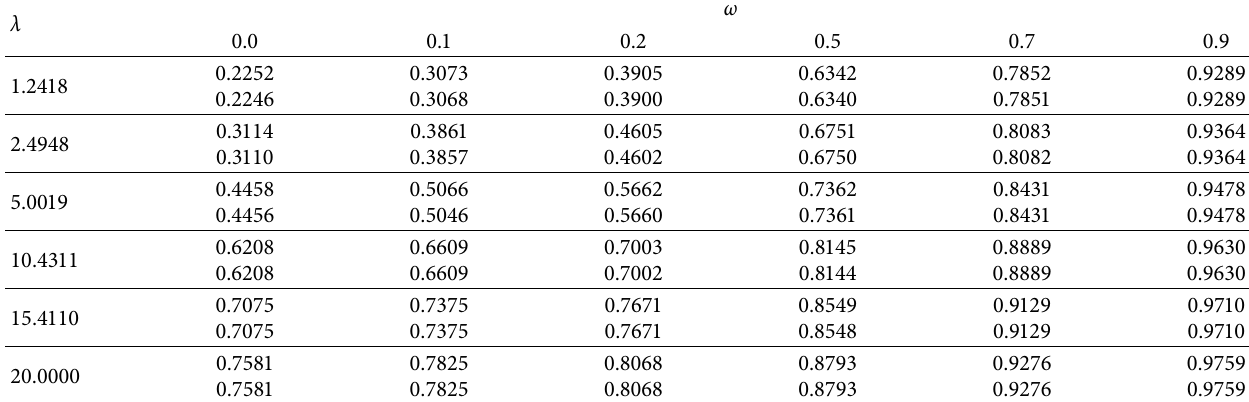
Table 3: Values of risk ratios R and λ � ‖ ] ‖ 2